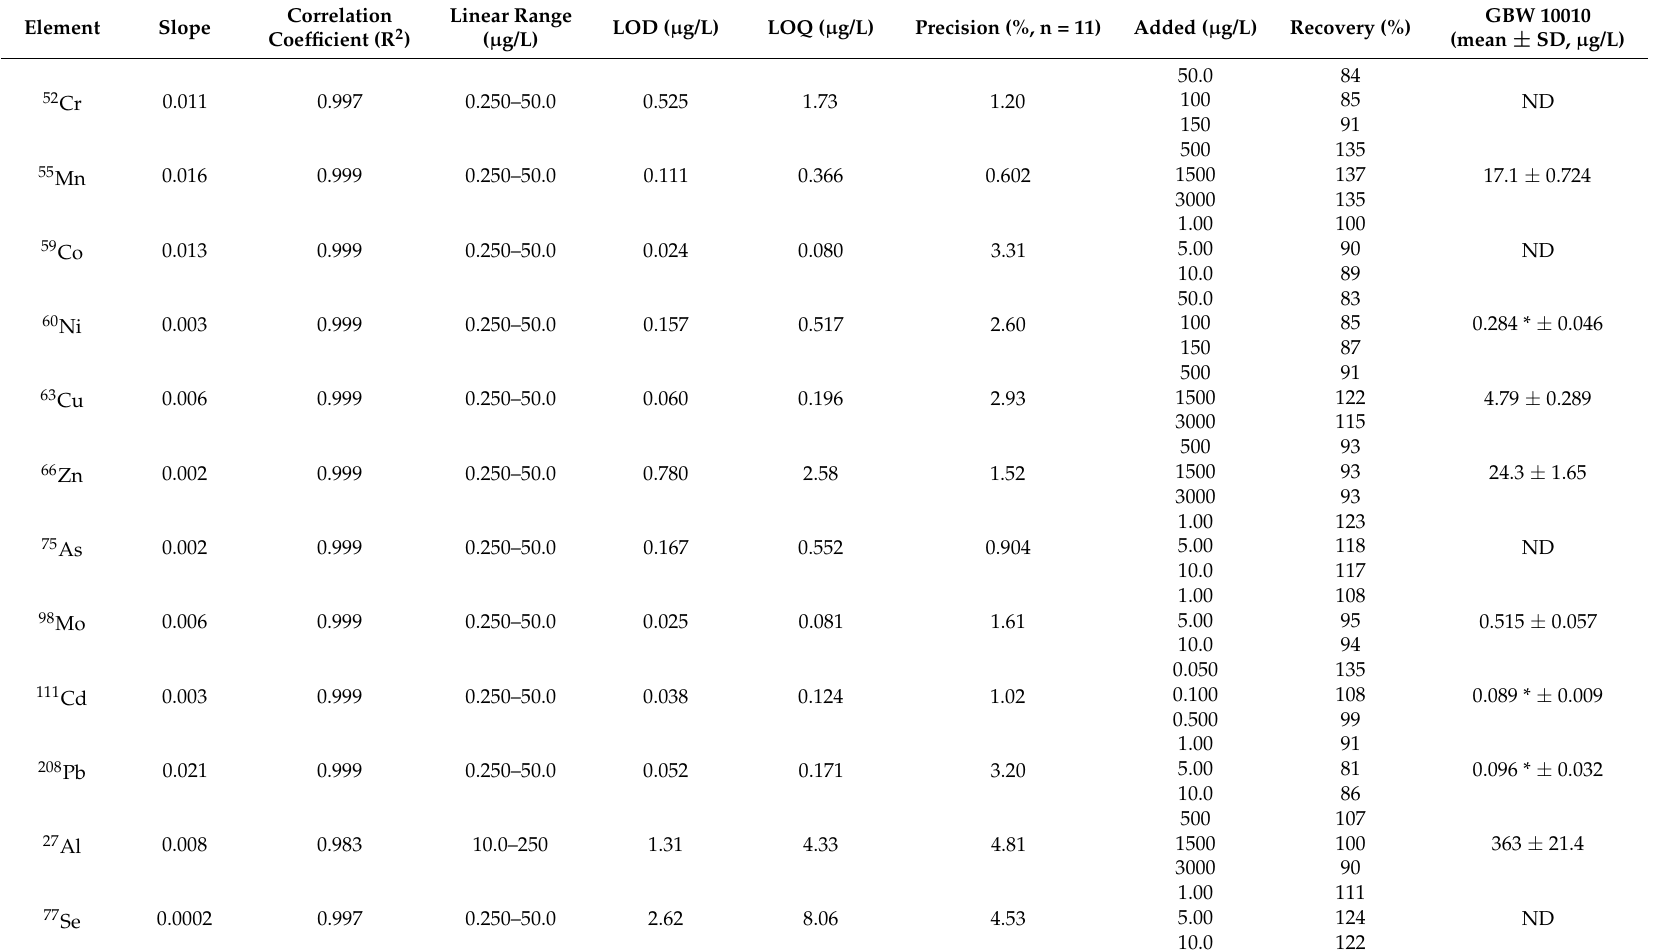
Table 1. The method verification results for the determination of trace elements in wine by